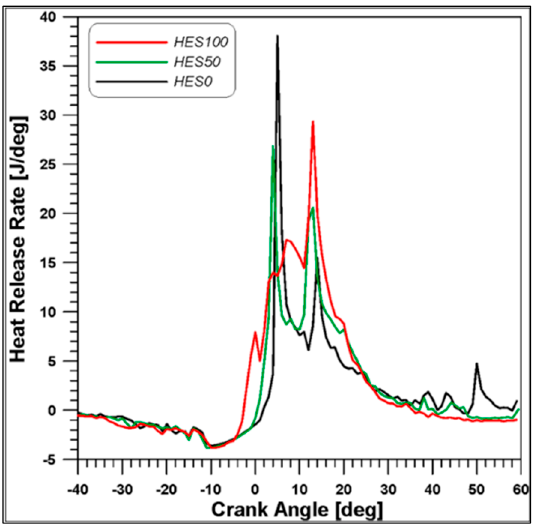
Figure 17. Rate of heat release.